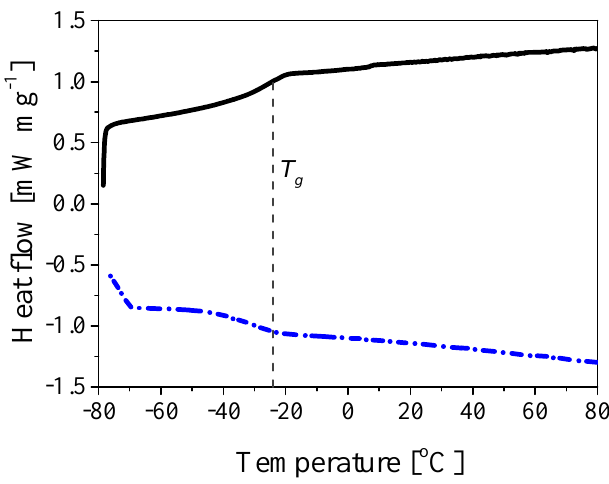
Figure 4. DSC curves of polymer a : heating (solid black) and cooling (dashed blue) heat flow